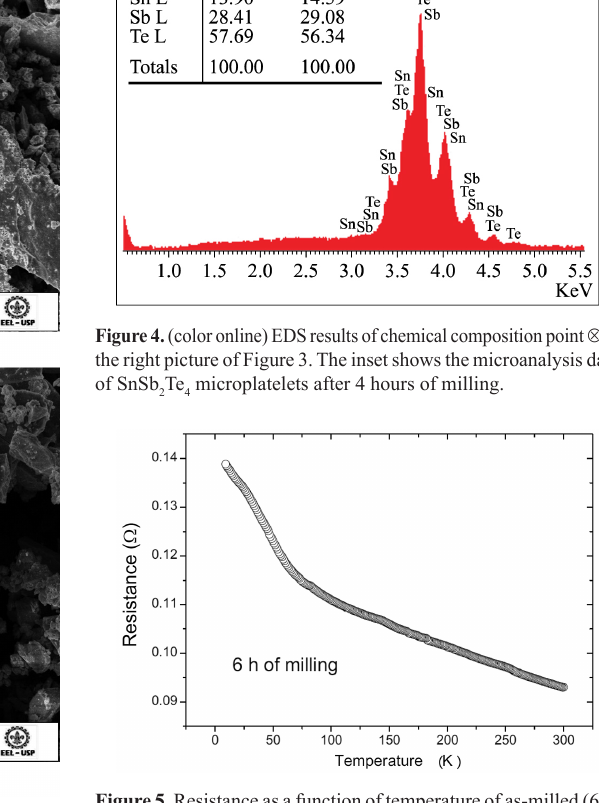
Te powders after 4 hours of milling. 2 4